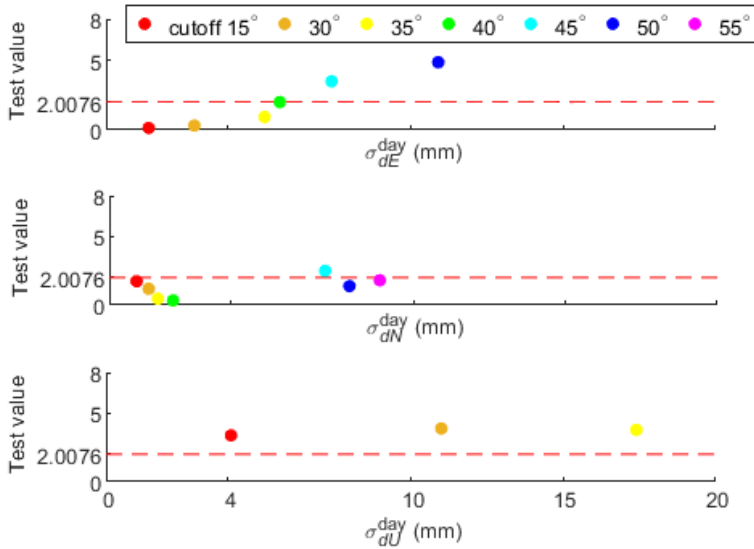
Figure 8. Test values of Student’s t -test for masking conditions level. The azimuth cutoff is from 90° to 270°. The five-constellation PPP is adopted during the process. The top, middle and bottom pan- els refer to the E, N and U directions, respectively. From another aspect, Figures 7 and 8 show that the computed test values start to become close to or larger than the threshold when d a y d N  , d a y d E  or d a y d U  are larger than 0.4 cm. This result implies that a criterion, in which the standard deviation of the daily solution should not be larger than 0.4 cm, can be made for users to judge whether the wall point is certain in monitoring SLDW. When the criterion holds true, for five-constellation PPP, Figure 8 shows the computed test values in the horizontal and vertical directions can be smaller than the threshold when the elevation cutoffs are lower than 45°and 15°, re-